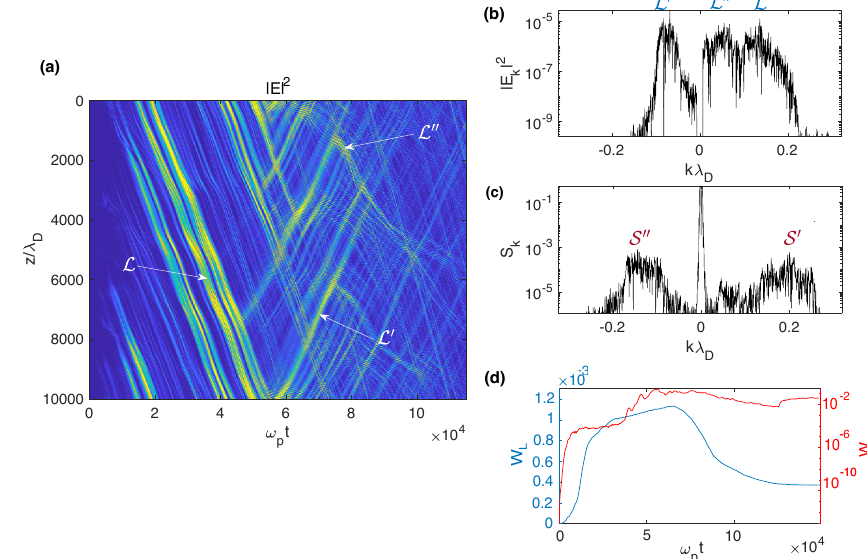
Figure 9. Inhomogeneous plasma. ( a ) Space-time variations of the Langmuir energy density | E | 2 . ( b ) Langmuir wave energy spectrum at ω p t = 89,000. ( c ) Ion acoustic wave energy spectrum S k at ω p t = 89,000. ( d ) Time variations of the energy densities W L and W S of the Langmuir (blue) and ion acoustic (red) waves. Main parameters are the following: ∆ n = 0.01, v b / v T = 18, n b / n 0 = 5 × 10 − 5 , c s / v T = 0.045, γ e , γ i (cid:54) = 0 (wave damping is included). Langmuir and ion acoustic wave packets participating to decay processes are indicated by arrows in ( a ). All variables are